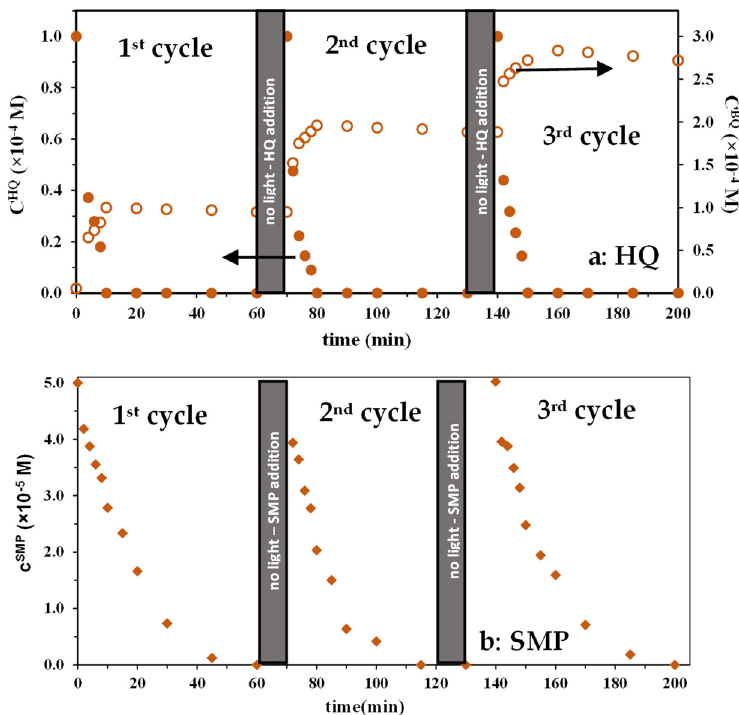
Figure 9. The transformation of HQ and formation of BQ ( a ) and the transformation of SMP ( b ) during three consecutive cycles in aerated BiOI suspensions, irradiated with Vis LED (c 0 (HQ) = 1.0 × 10 − 4 M; c 0 (SMP) = 5.0 × 10 − 5 M; c 0 (PDS) = 5.0 × 10 − 4 M).